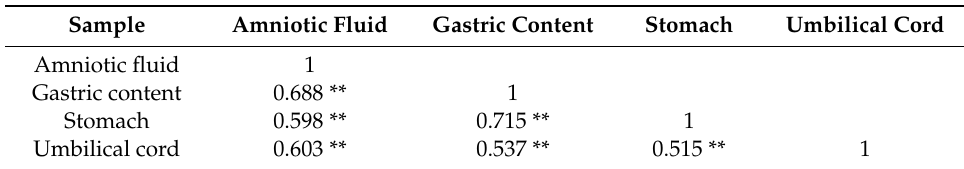
Table 2. Correlation matrix of leptin content in amniotic fluid, gastric content, stomach, and umbilical